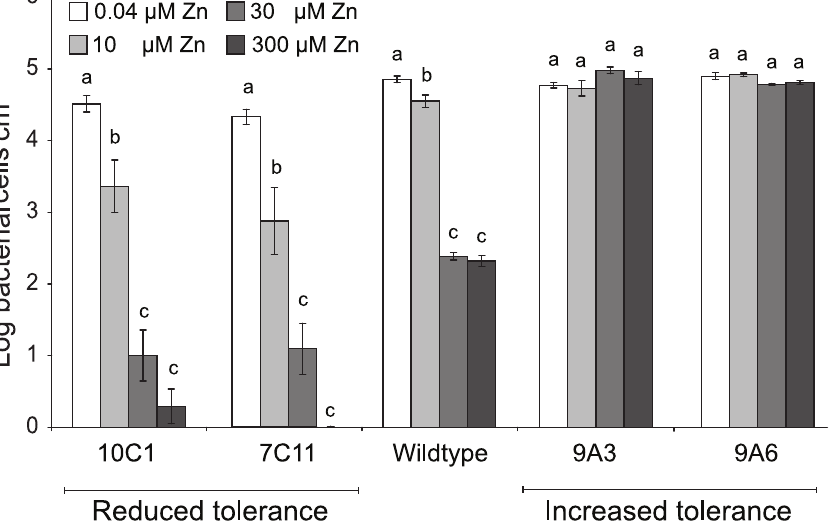
Figure 7. P.syringae pv. maculicola M4 mutants with altered zinc tolerance show differential growth in Thlaspicaerulescens. T. caerulescens plants were treated with 0.04, 10, 30, or 300 m M zinc. Nine leaves of three plants were infiltrated with either P. syringae pv. maculicola M4 or one of four zinc-tolerance mutants (9A6, 9A3, 7C11, or 10C1) suspended in 10 mM MgCl 2 at 10 6 cfu/ml. Leaves were sampled for bacterial counts at 0 and 5 days after inoculation. Each replicate consisted of three leaves from one plant, giving a total of three replicates per time point and treatment. Values are means 6 SE ( n =3). The experiment was performed three times with similar results, and the results shown are from one experiment representative of the three. ANOVAs were used to test for a significant effect of plant zinc treatment on the growth of each bacterial strain. No effect was detected for the high tolerance mutant 9A3 ( P =0.13). For the other strains, growth was found to be dependent on zinc (9A6: P =0.01; wild-type, 7C11 and 10C1: P , 0.0005 in each case). Where a significant effect was found, Bonferroni simultaneous comparisons ( a =5%) were carried out. Within each strain, means marked with the same letter were not significantly different.